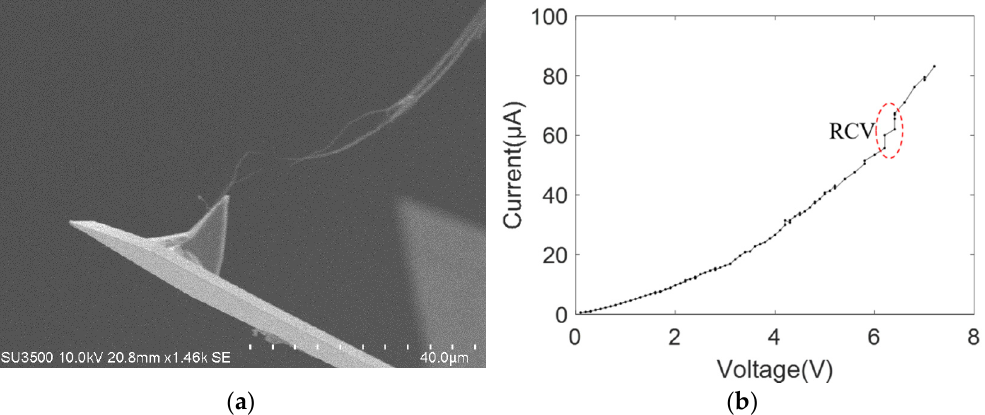
Figure 5. MWCNT bundle contacting with one gold-coated AFM probe ( a ) SEM image; ( b ) cur- rent–voltage